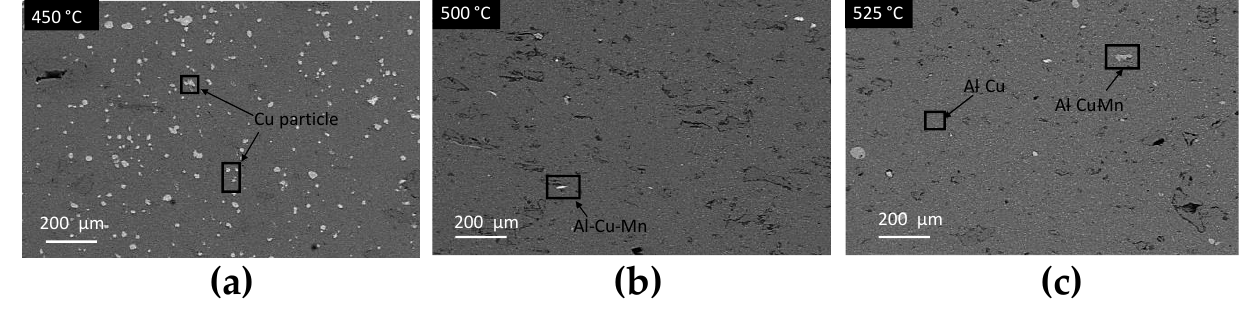
Figure 10. SEM images (BSE mode) at a 200× magnification of heat-treated compacts: ( a ) 450 °C, 1 h; ( b ) 500 °C, 1 h; ( c ) 525 °C, 1 h.